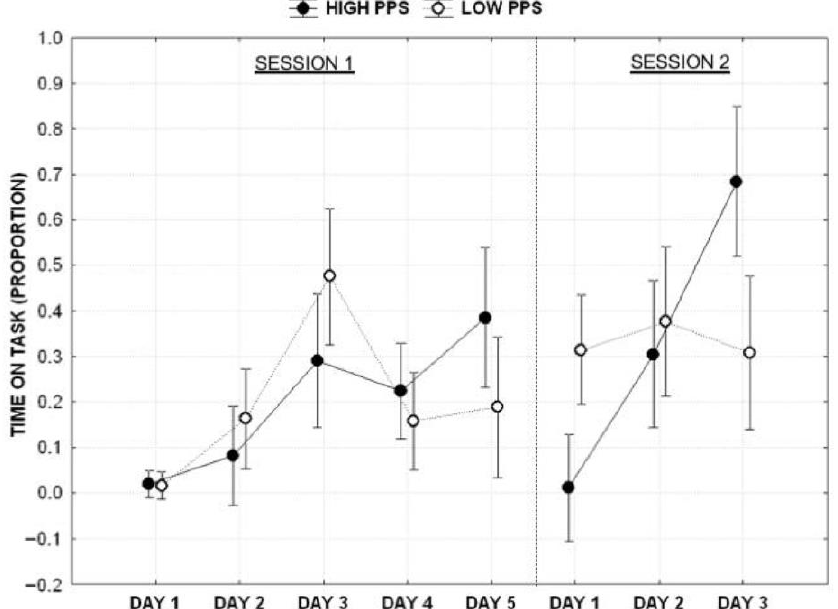
Figure 3. Proportion of time dedicated to the writing task separately per session, day, and category of subjects. Vertical bars denote 0.95 confidence intervals.